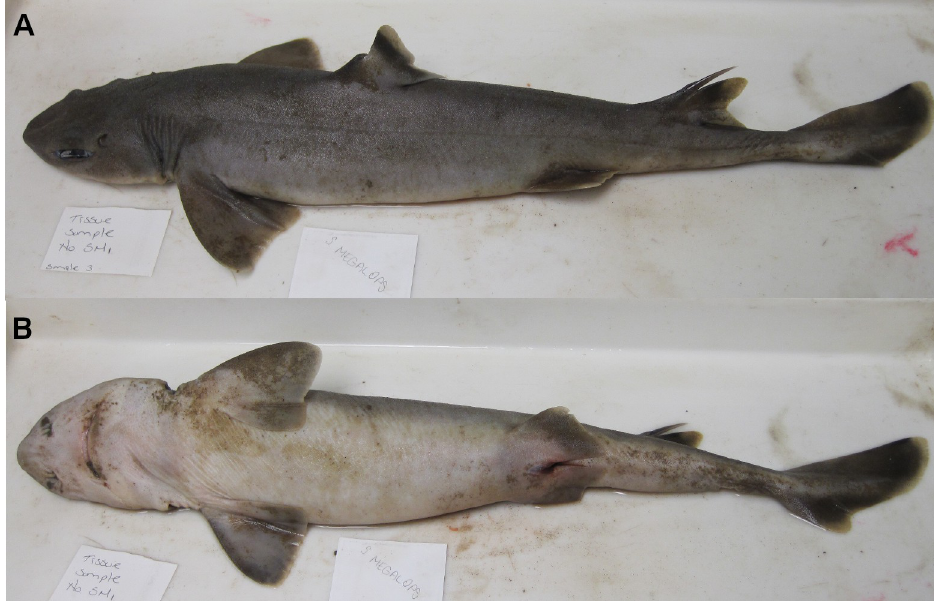
Fig 26. Fresh specimen of C . asper in lateral (A) and ventral (B) views, SAIAB 186460, juvenile female, 456 mm TL, South Africa. Reprinted from NRF-SAIAB under a CC BY license, with permission NRF-SAIAB,